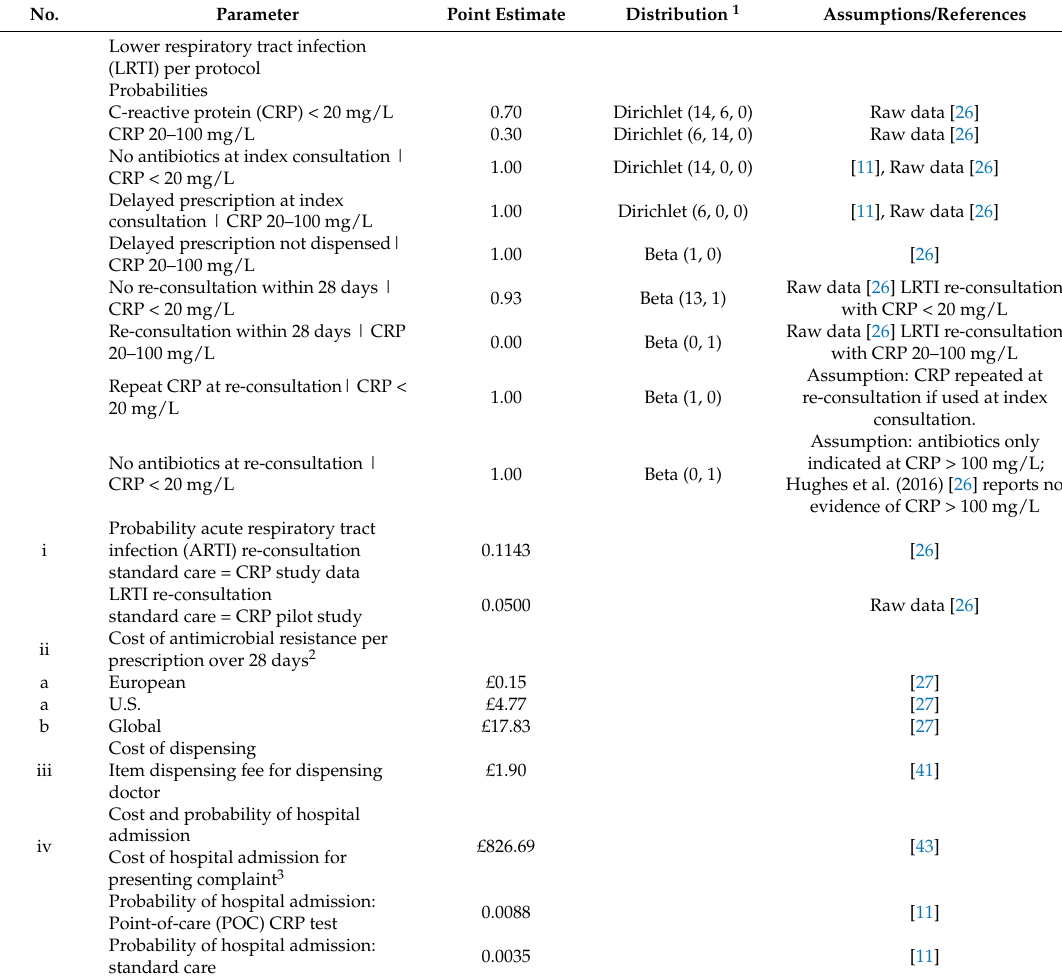
Figure 4. Decision tree for POC CRP testing adhering to guidelines, LRTI only. POC: Point-of-care; CRP: C-reactive protein; * Amoxicillin 500 mg three times daily for 5 days. Table 5. Model parameters for sensitivity analysis.